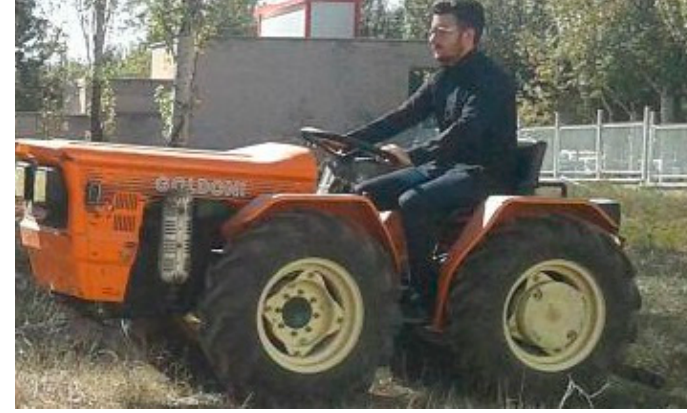
Figure 1. A four wheel drive (4WD) Goldoni model 240 tractor. Table 1. Tractor characteristics.